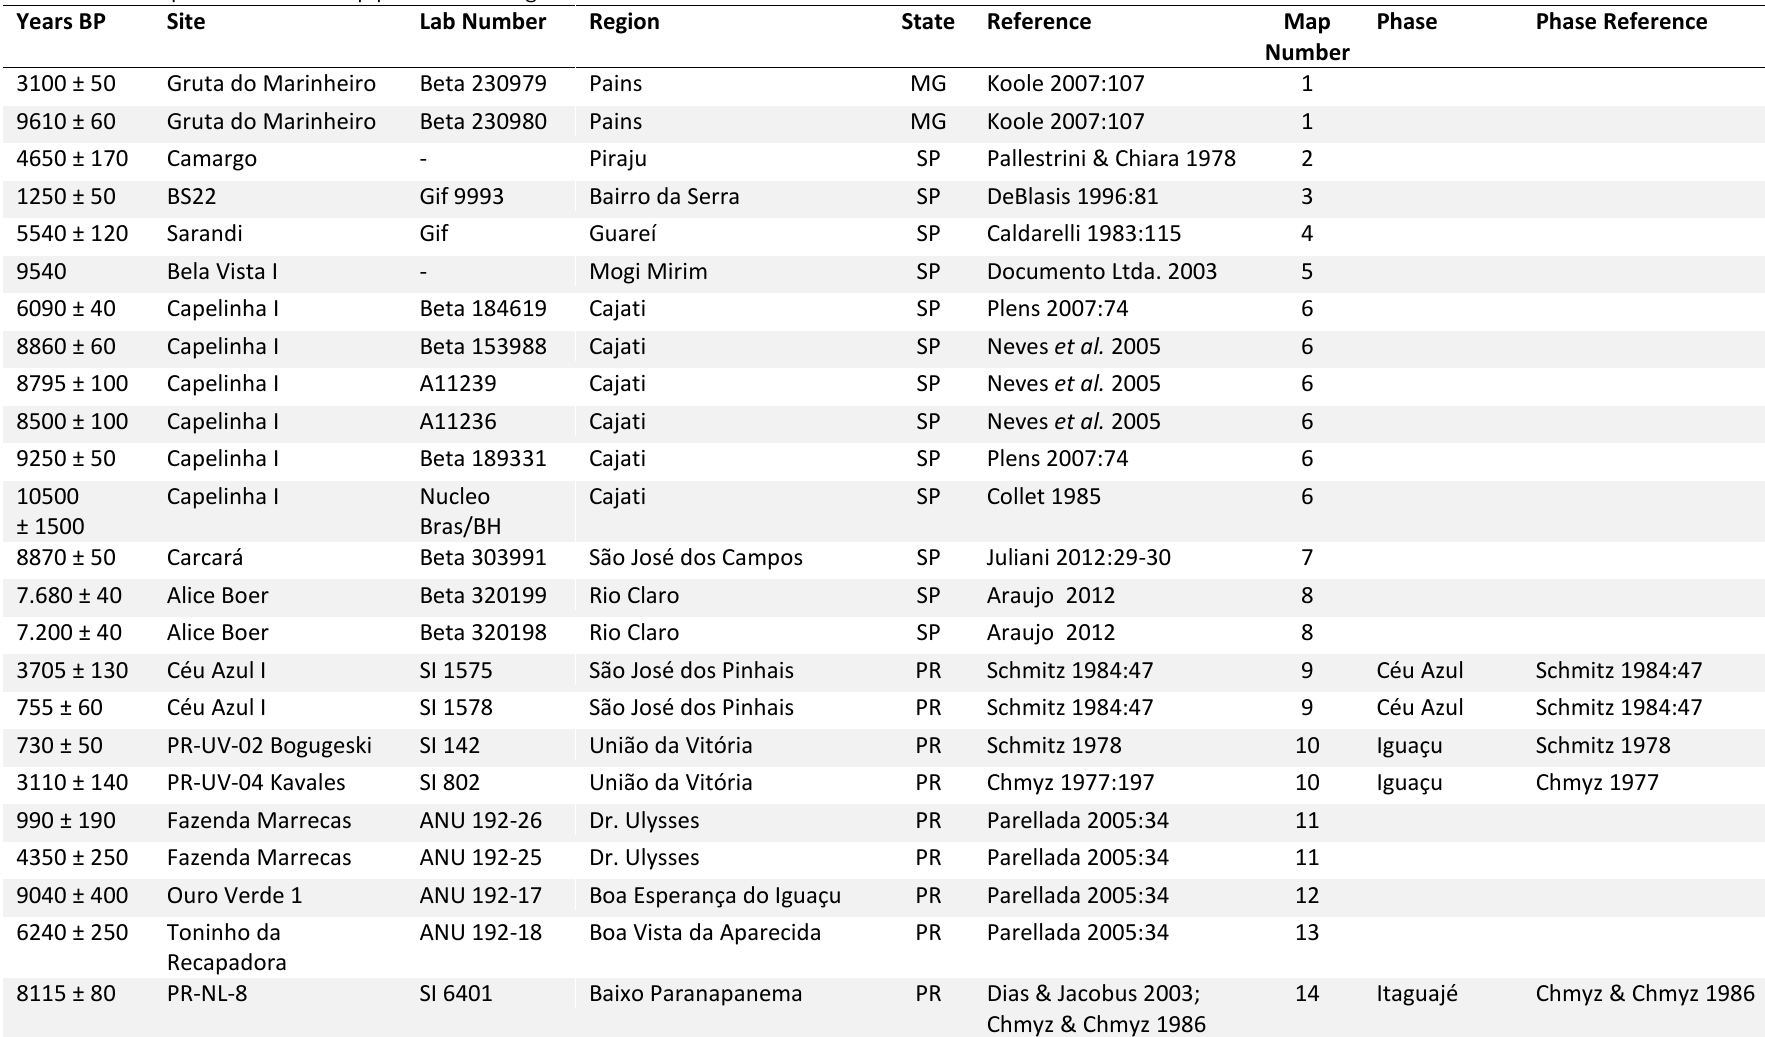
Table 1: Archaeological sites from southern and southeastern Brazil presenting bifacial points dated from the Late Pleistocene to the eve of the historical period. The column “number on map” refers to the map presented in Figure